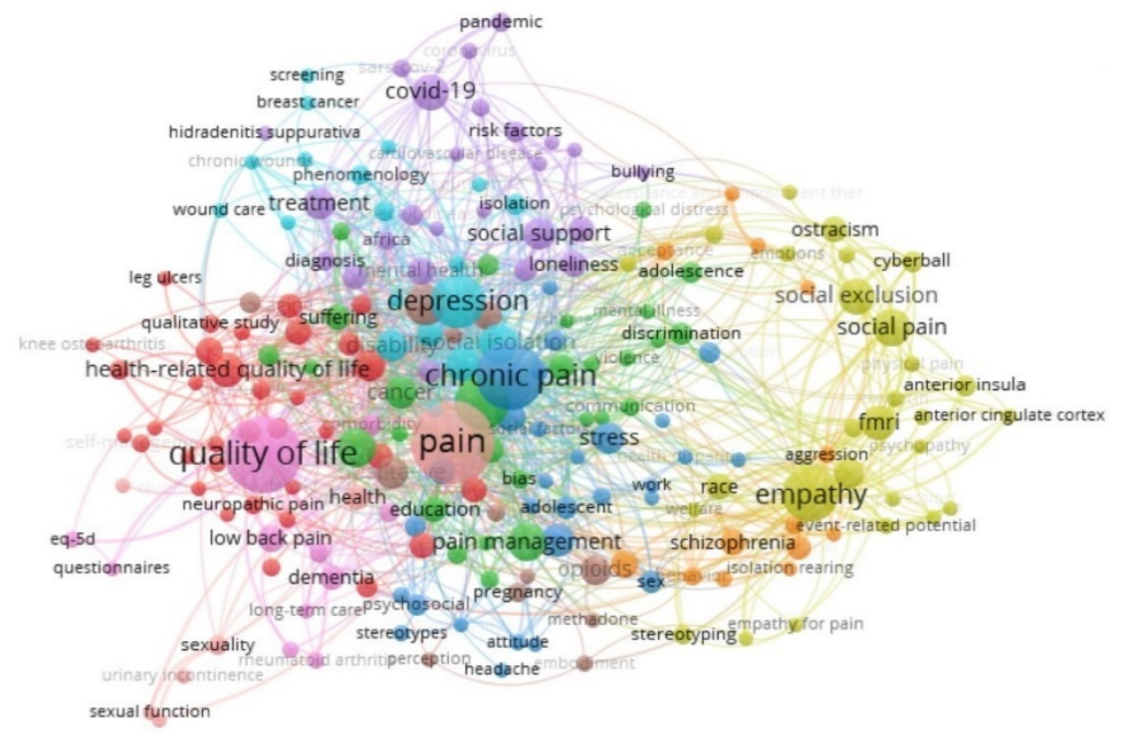
Figure 1. Chart showing the main nodes (keywords) applying the original unfiltered strategy on Scopus (Using the VOSviewer software (Centre for Science and Technology Studies, Leiden University, The Netherlands. Version 1.6.16.)).